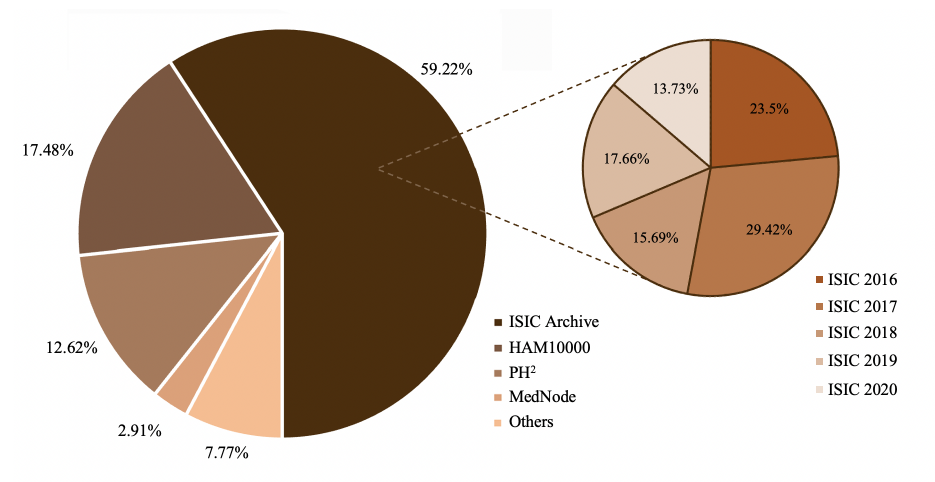
Figure 4. Analysis of datasets used. The “others” category includes DermIs, DermQuest, IDS, 7 point check list and DermNZ datasets.